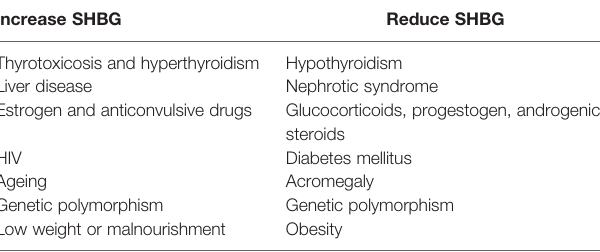
TABLE 3 | Conditions that modify SHBG serum